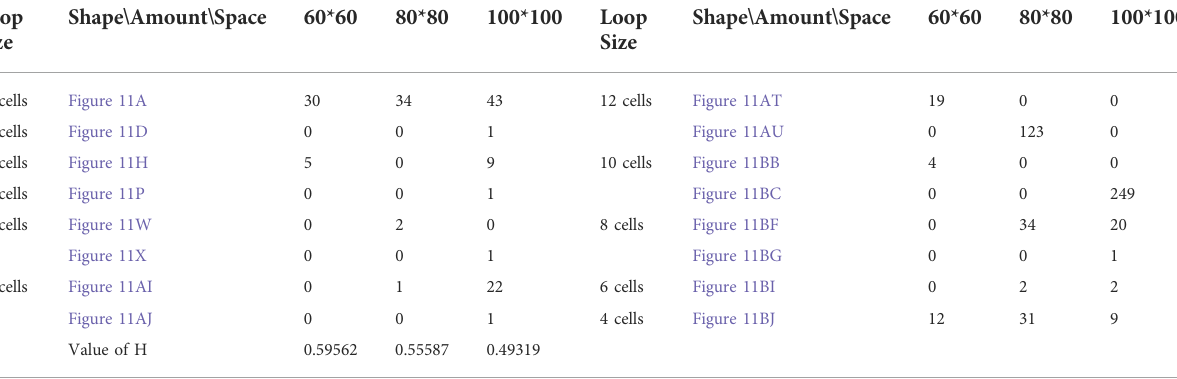
TABLE 11 Statistical numbers of the loops with various structures for the greedy selection mechanism on different cellular spaces starting from the initial con fi guration in Figure 7D. Loop Size